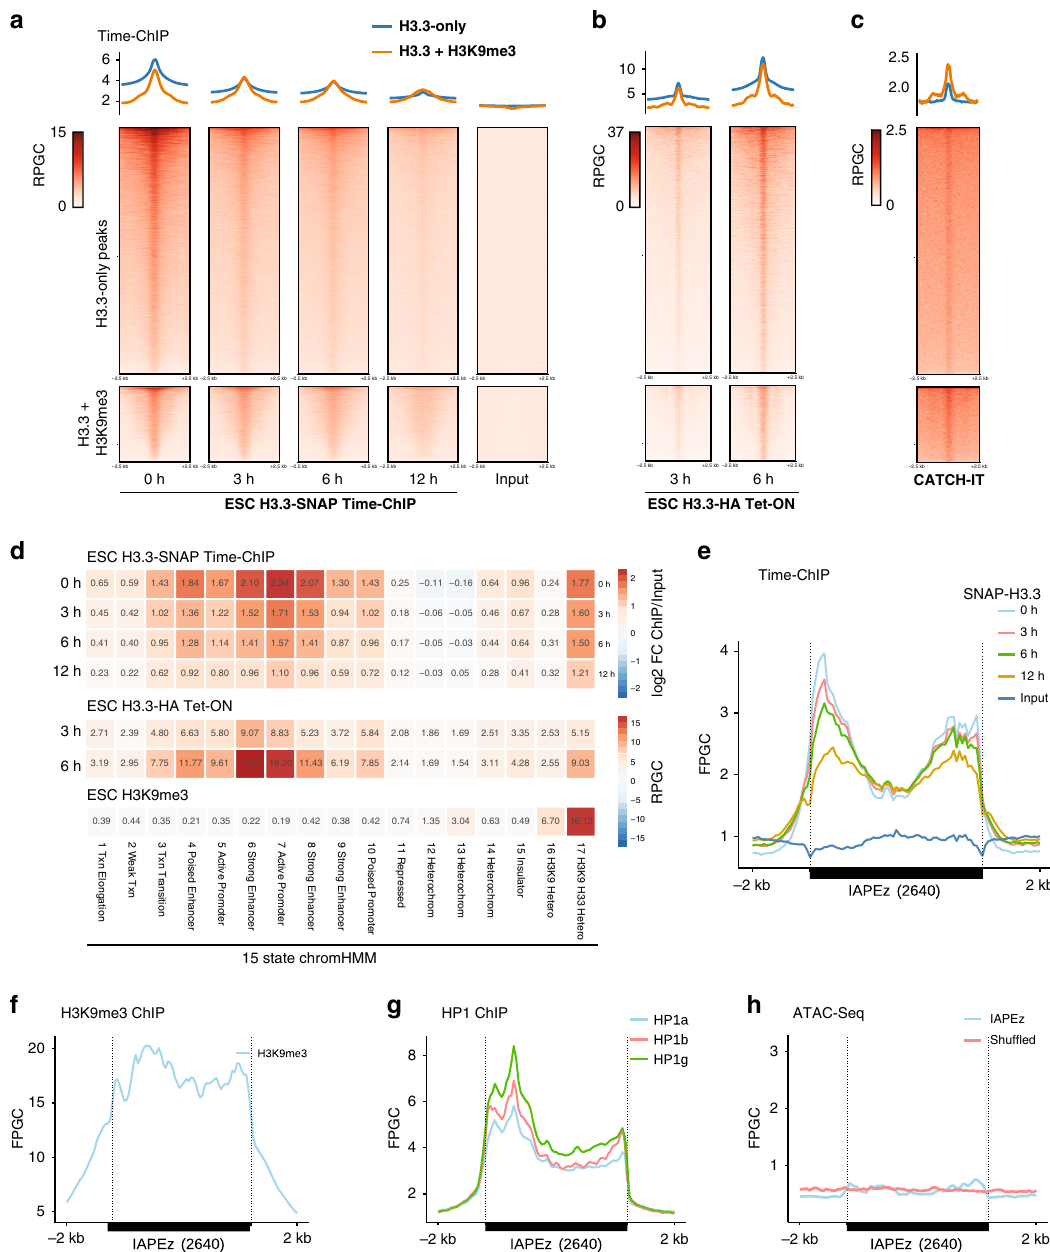
Fig. 2 Rapid histone turnover at interstitial heterochromatin in the absence of DNA accessibility. a Read density heatmaps and average pro fi les of H3.3- SNAP time-ChIP data 9 over two classes of H3.3 peaks, H3.3-only and H3.3 + H3K9me3 peaks. All data is normalized to Reads Per Genomic Content (RPGC). b Read density heatmaps and average pro fi les of H3.3-HA pulse data 34 over H3.3 peaks. c Read density heatmaps and average pro fi les of CATCH- IT data 6 . d Mean read density heatmap showing enrichments of H3.3-SNAP time-ChIP (log2-fold change over input) over 15 ChromHMM states 37 as well as H3K9me3 and H3.3 + H3K9me3 enriched regions 21 . Additional replicates are shown in Supplementary Fig. 5b. For enrichment analysis by repeat families see also Supplementary Fig. 6. Source data are provided as a Source Data fi le. e Average coverage of H3.3-SNAP time-ChIP over 2640 shared IAP ERVs. Fragments de fi ned by paired-end reads were piled up and normalized by 1x Genome coverage (Fragments Per Genomic Content, FPGC). See Supplementary Fig. 5c for coverage of uniquely mappable reads only. f Average coverage (FPGC) of H3K9me3 ChIP 71 over 2640 shared IAP ERVs. g Average coverage (FPGC) of BioChIP for HP1 isoforms 72 over 2640 shared IAP ERVs. h Average pro fi les of DNA accessibility 20 over 2640 shared ERVs, and 2640 random (shuf fl ed) genomic regions of matching size. Source data are provided as a Source Data fi